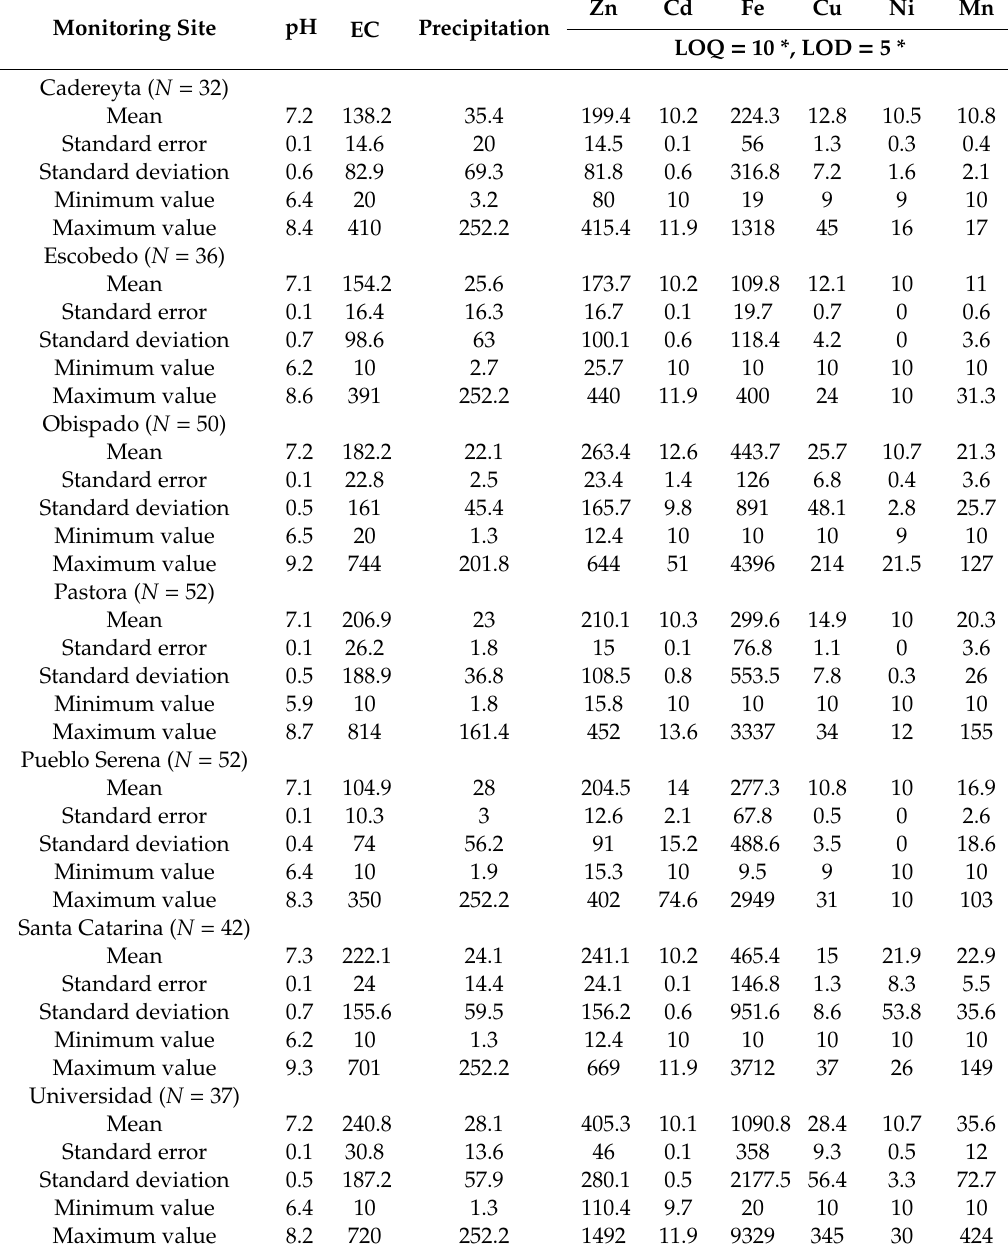
Table 1. Descriptive statistics for pH, EC ( µ S cm − 1 ), and annual metal concentration ( µ g L − 1 ) by monitoring